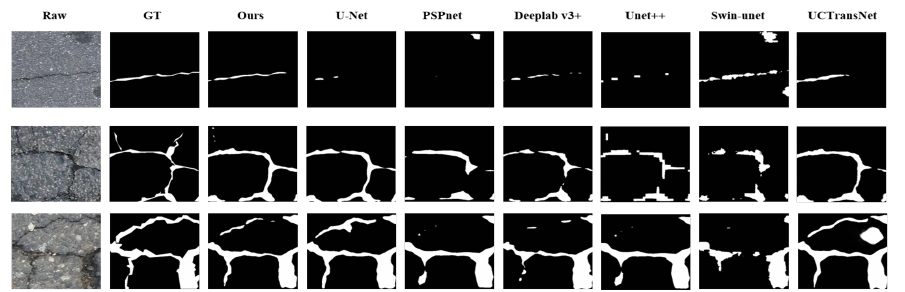
Figure 10. Comparison of the results of different methods for selected crack images from the test set.